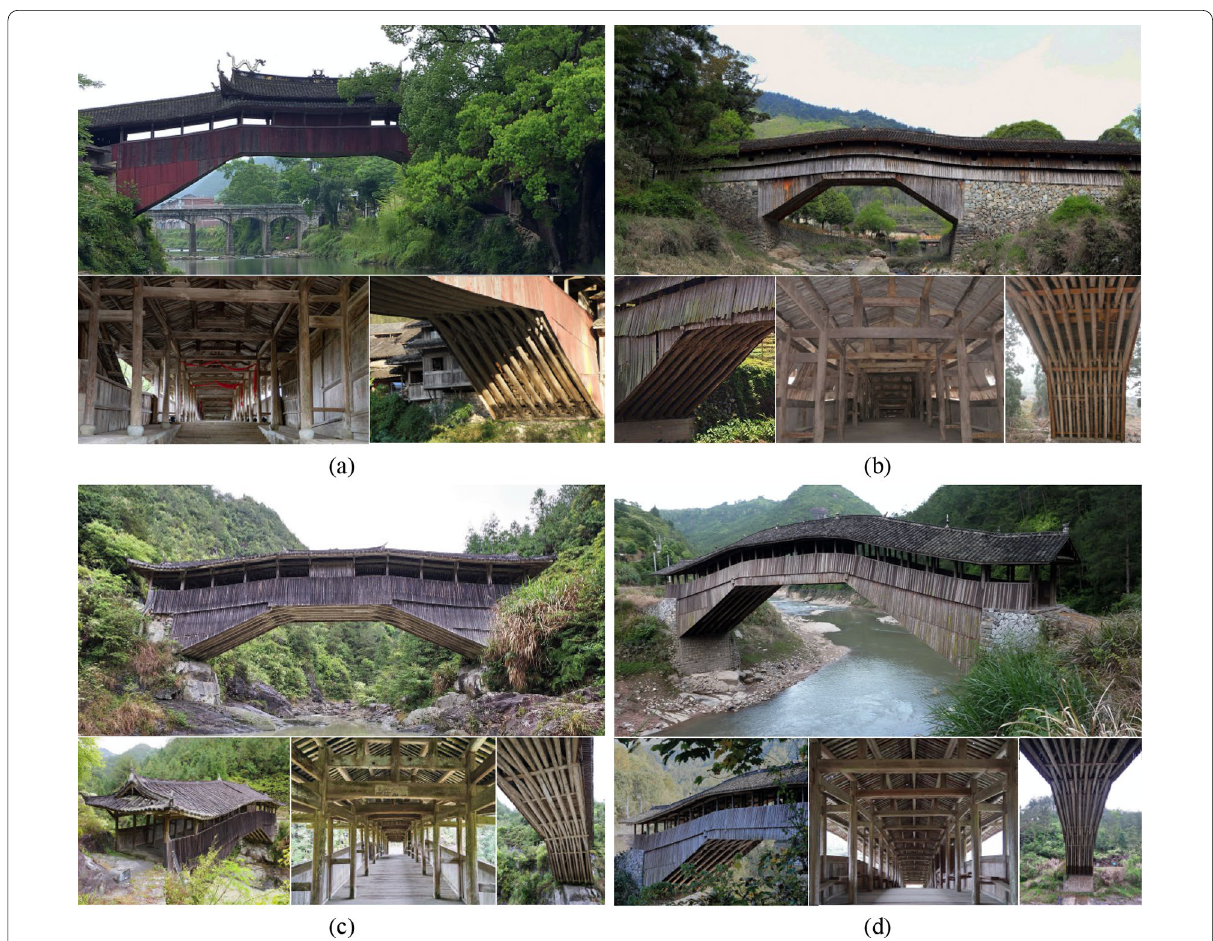
Fig. 2 Some existing ancient timber arch lounge bridges: a Beijian Bridge, b Huangshui Bridge, c Santiao Bridge, and d Xianju